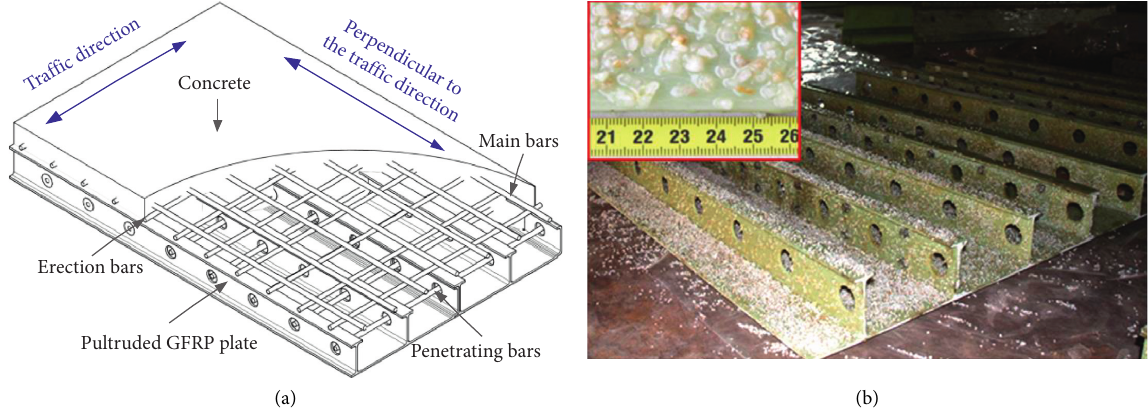
Figure 13: Hybrid deck system proposed by Zuo. (a) Schematic view. (b) The sand bonded GFRP